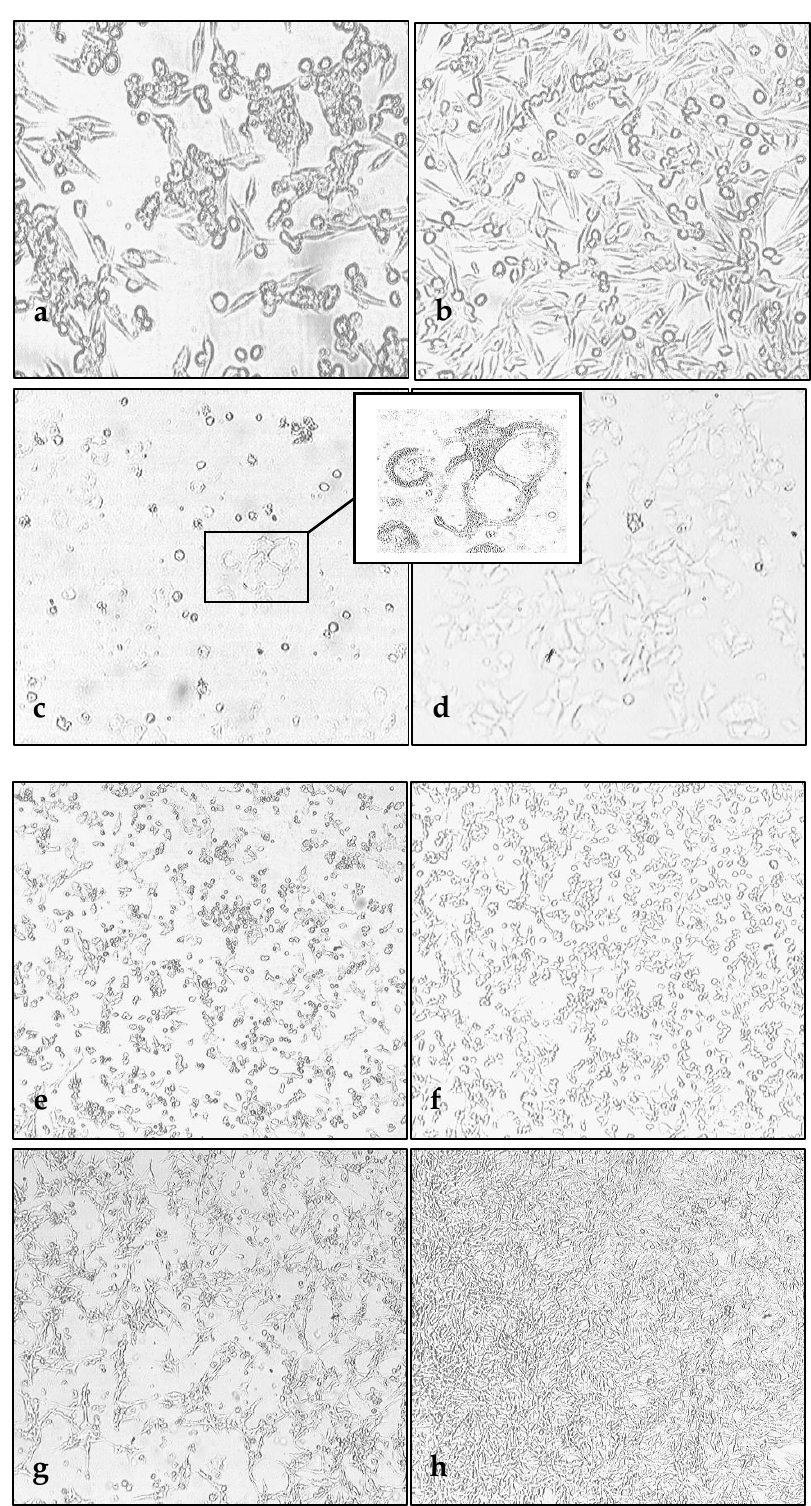
Figure 1. Oncolytic activity of MV L-16 strain against human melanoma cell lines at 72 hours post infection. Mel Il (a–b, 20×), mel Ibr (c–d, 10×), mel Mtp (e–f, 10×) and mel Z (g–h, 10x) cell lines were infected by MV at a MOI of 1.0 (left column) or mock-infected (right column). The characteristic syncytia formation is highlighted in the footnote.